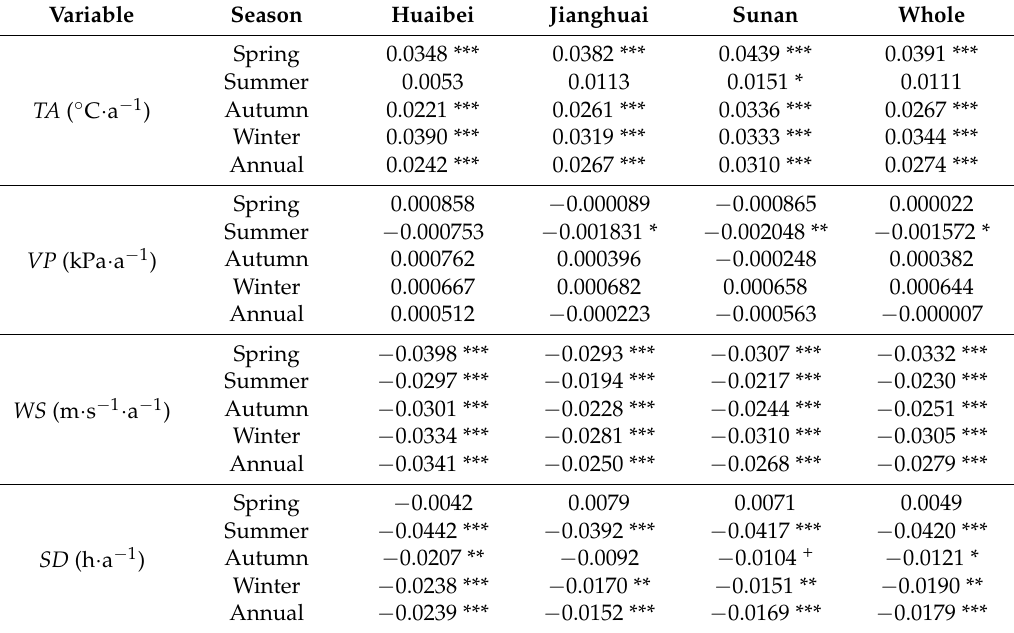
Table 3. Temporal trends for climatic factors in Jiangsu province from 1961 to